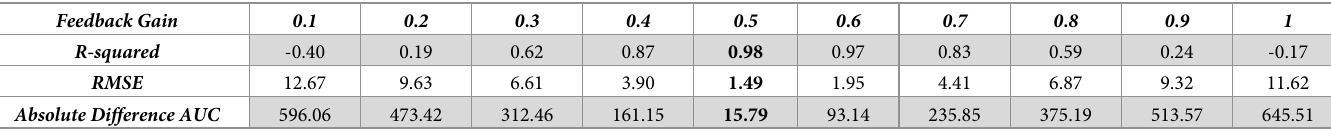
Table 2. Goodness-of-fit statistics for behavioral dataset for vocal f o reflexive paradigm explained by model simulations. AUC = area under the curve. Feedback Gain